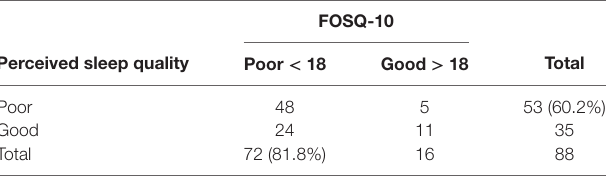
TaBle 3 | Concordance between perceived sleep quality and Functional Outcomes of Sleep Questionnaire (FOSQ)-10 questionnaire for all workers. FOsQ-10